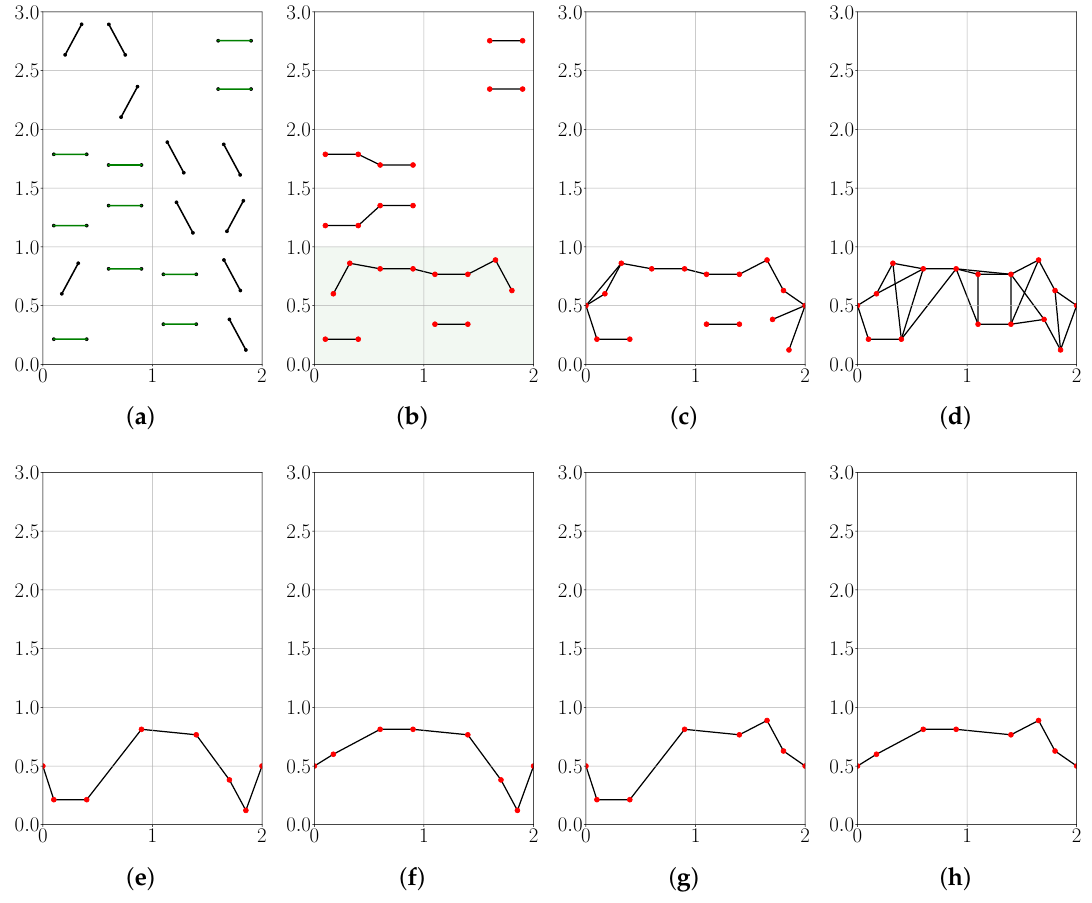
Figure 4. Proposed method description: The above figures show a step-by-step description of proposed method for estimating failure paths based on the method outline in Section 3. ( a ) Cracks perpendicular to tensile loading (0-degree cracks); ( b ) Failure zone identification; ( c ) Node-to-Node connectivity; ( d ) Weighted graph based on 2- NN ; ( e ) Failure path-1 prediction; ( f ) Failure path-2 prediction; ( g ) Failure path-3 prediction; ( h ) Failure path-4